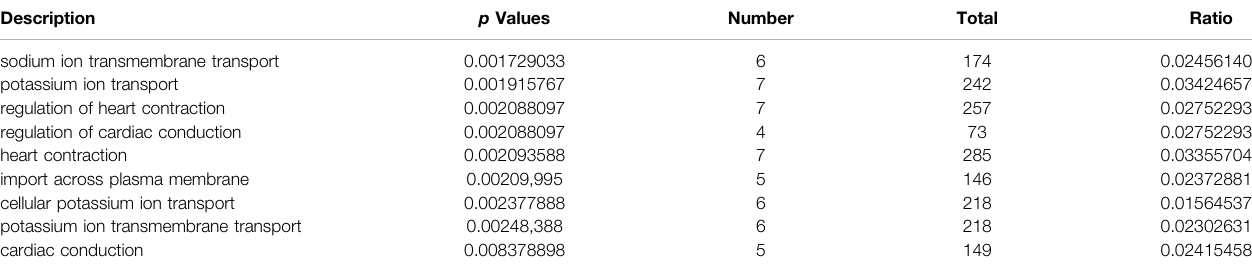
TABLE 5 | Enrichment analysis related to up/down-regulated gene expression using the integrated data.